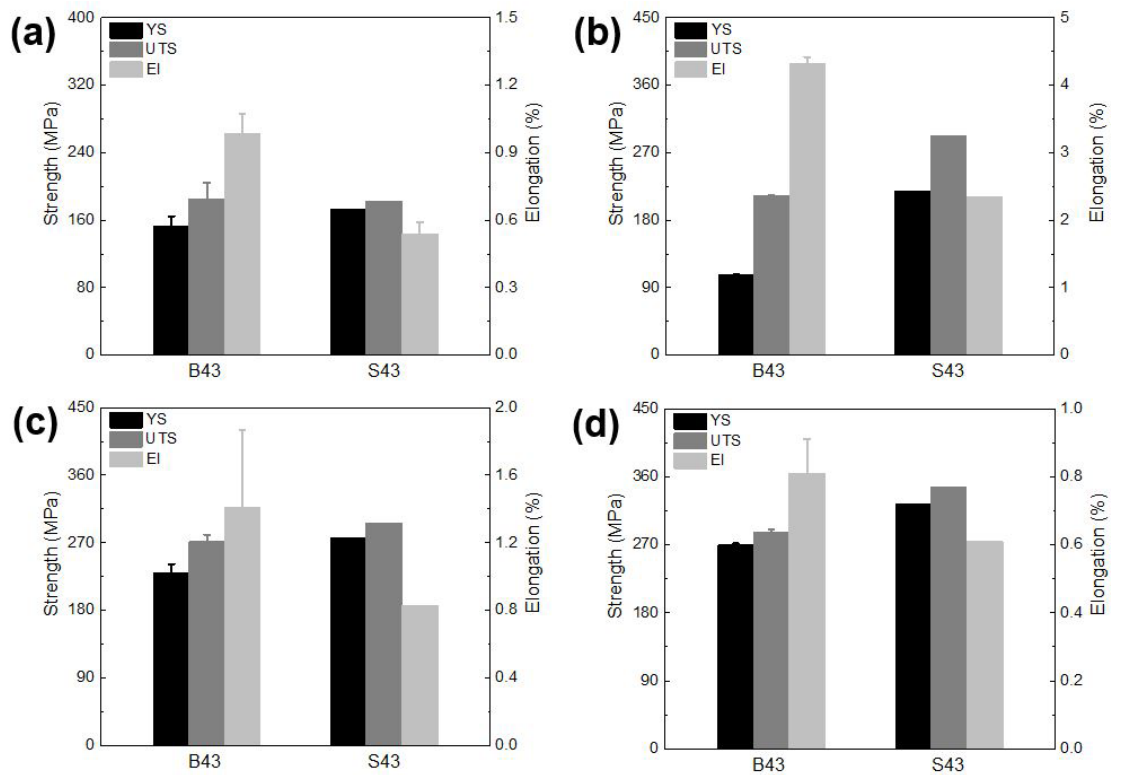
Figure 10. Tensile properties of the investigated alloys in different temper conditions: ( a ) as - cast, ( b ) as - quenched, ( c ) aged at 200 ° C for 8 h , and ( d ) aged at 200 °C for 16 h. ( b ) as-quenched, ( c ) aged at 200 ◦ C for 8 h, and ( d ) aged at 200 ◦ C for 16